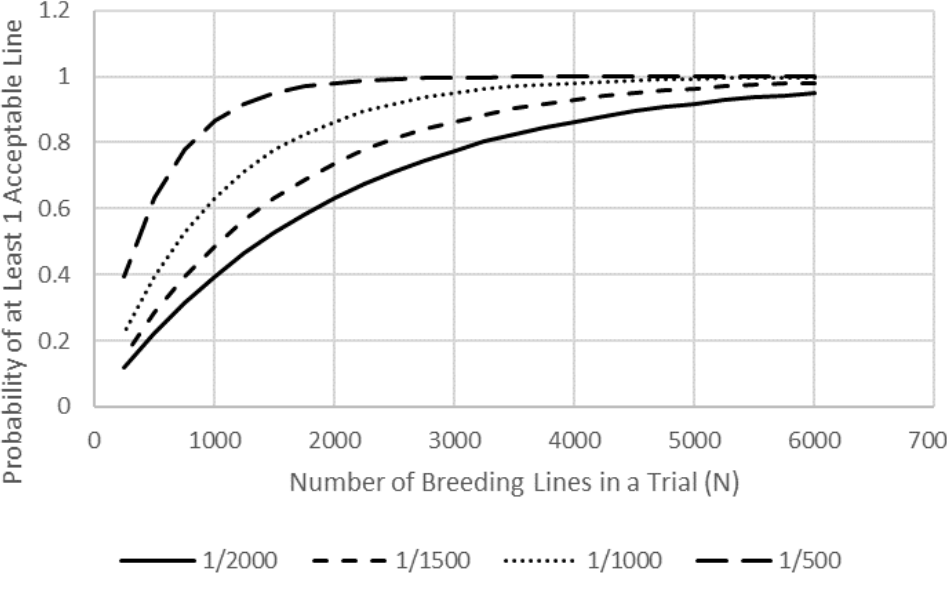
Figure 1. The probability ( P e ) that at least one line in a trial of size N is acceptable as a new cultivar given that the probability of a new cultivar ( P nc ) ranges from 1/2000 to 1/500.